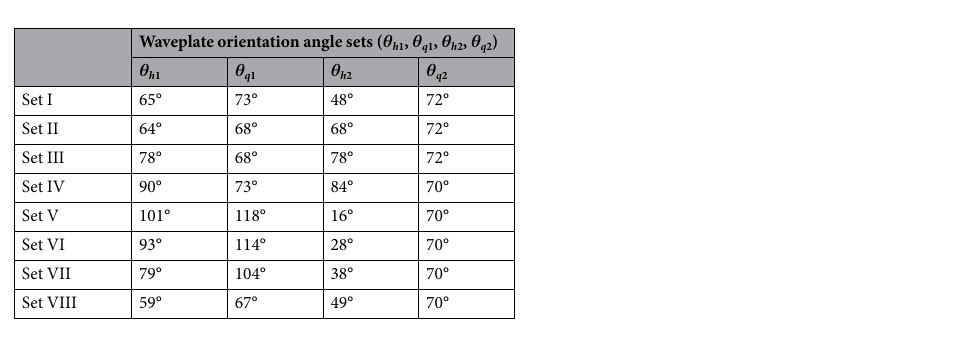
Table 2. Eight selected sets of waveplate angles for implementation of filter wavelength